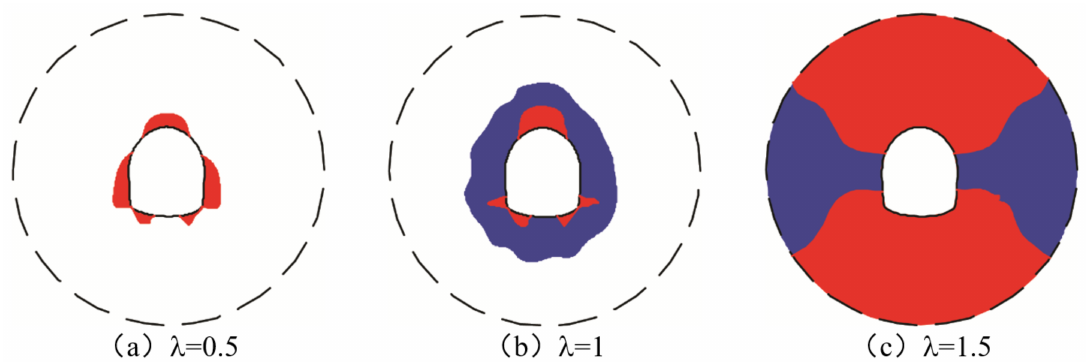
Figure 11. Range of strong and extremely strong rockburst in a single-track tunnel when σ v = 40